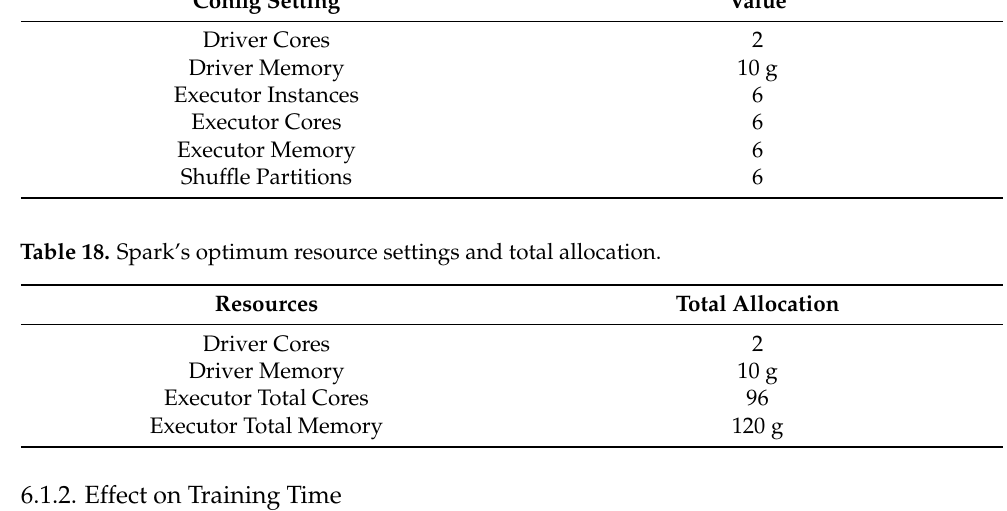
Table 17. Spark’s optimum configuration settings.